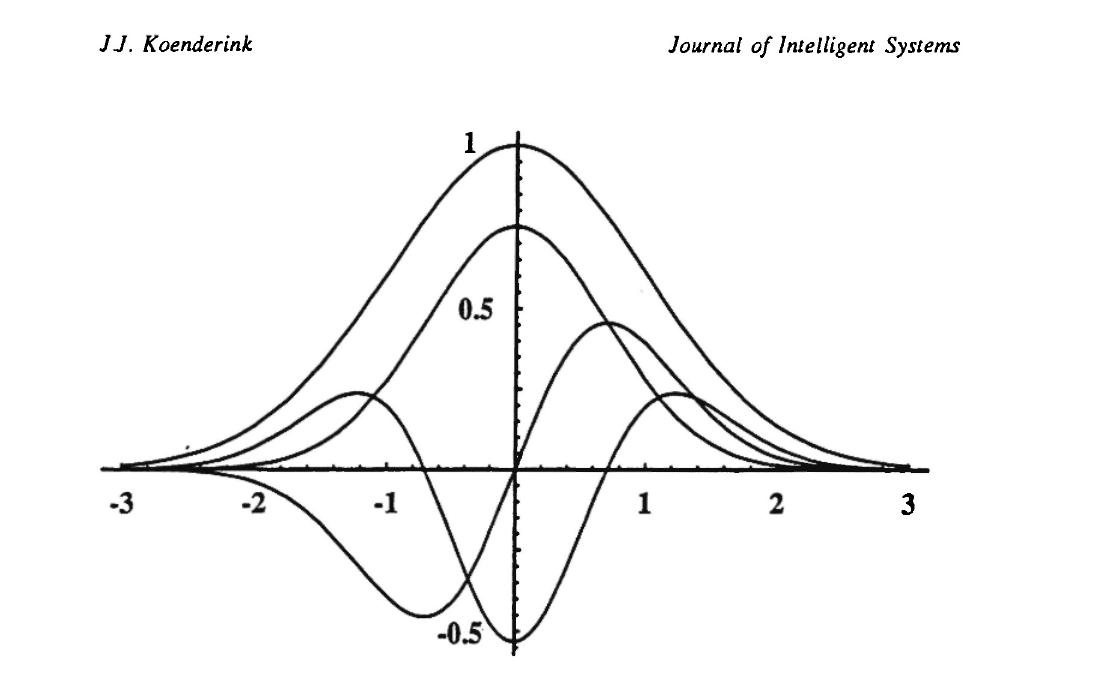
Fig. 8: The aperture function (wide Gaussian) and the zeroth (narrow Gaussian), first and second order operators in dimension